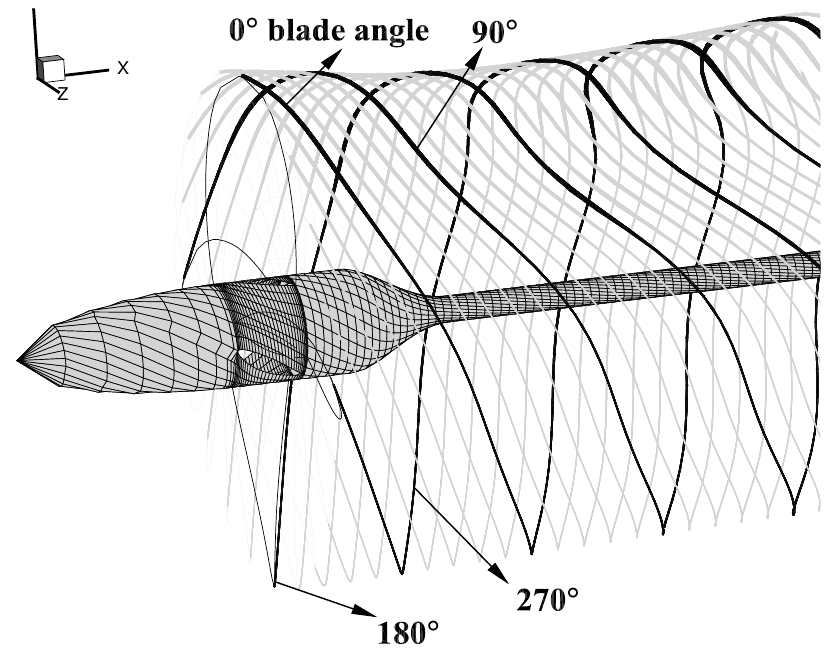
Figure 18. Developed tip vortex cavitation modeled by BEM during one period of propeller revolution: DTMB N4148 propeller, σ n = 2.576, J S = 0.954. Sheet cavity on the blade is not